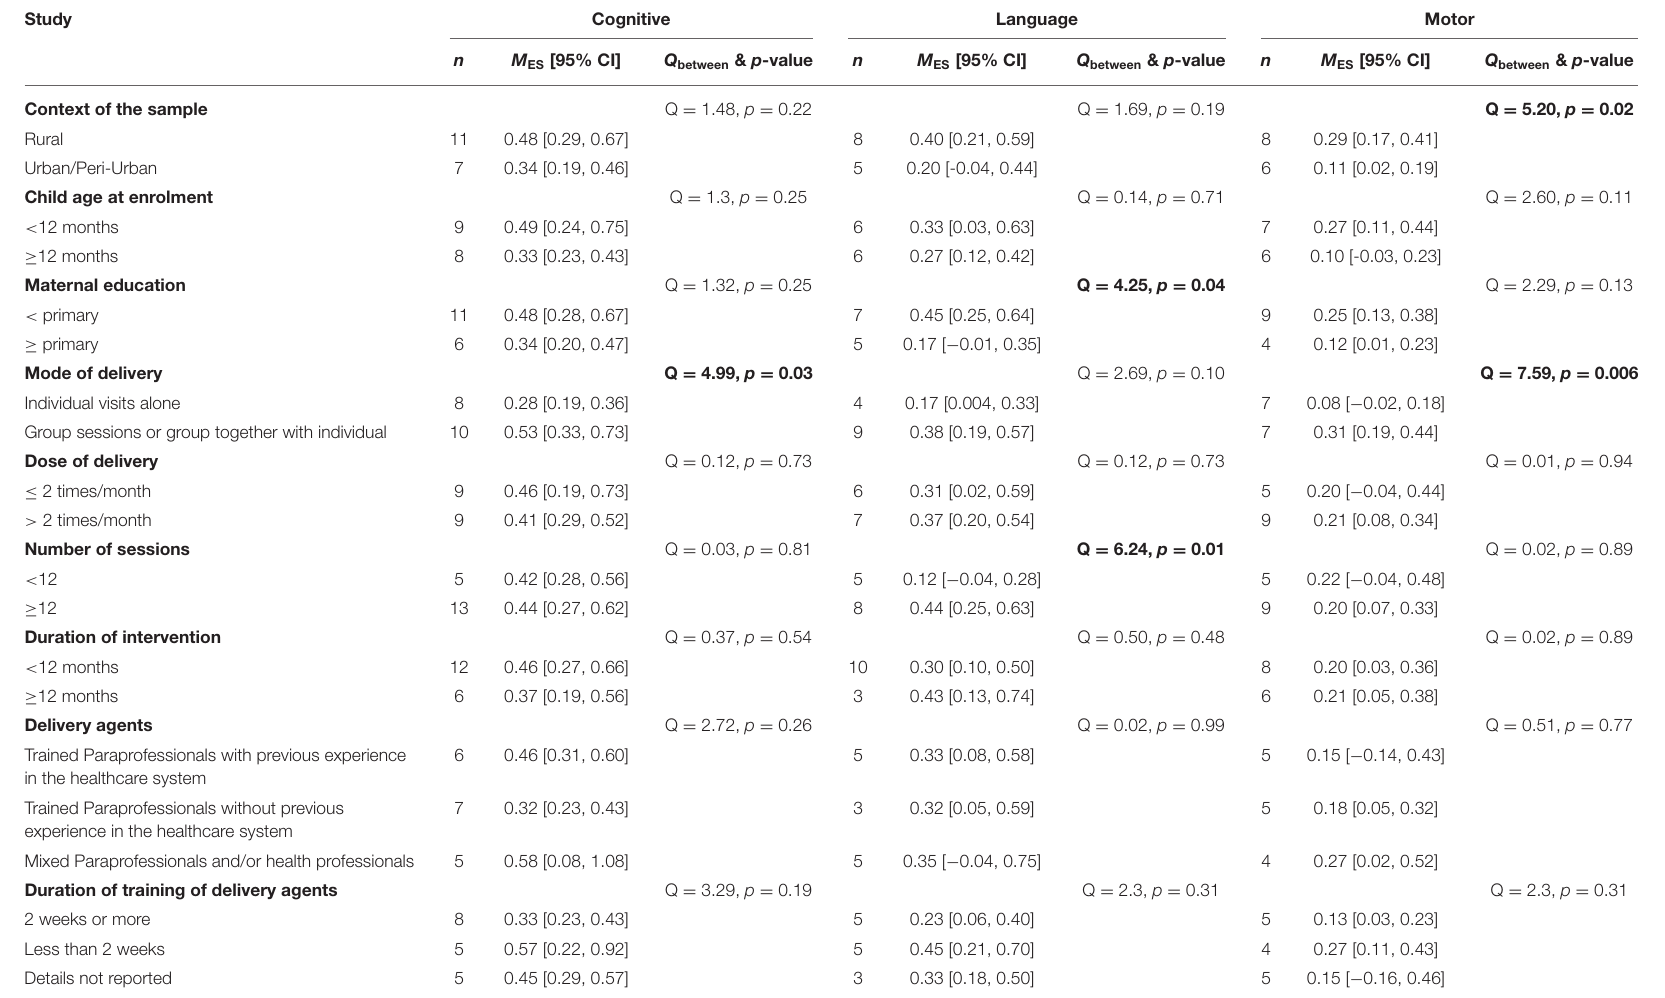
TABLE 4 | Effect sizes by